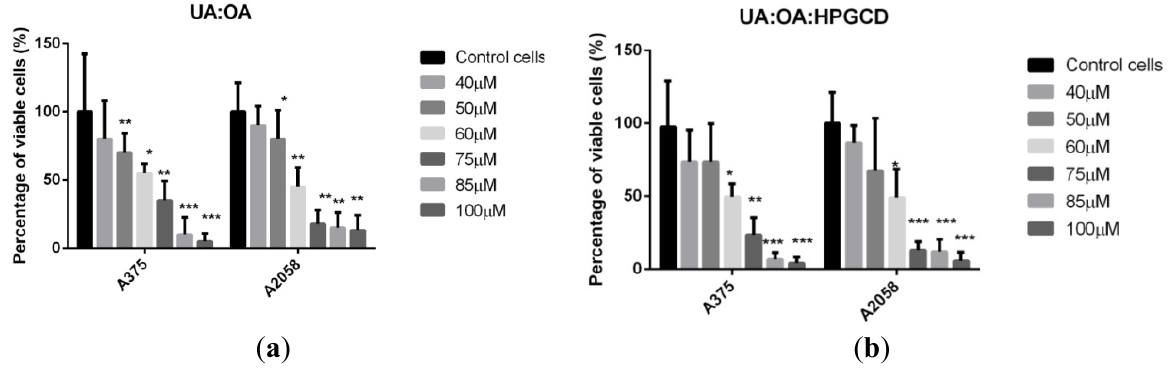
for the concentration of 75 µM ( p = 0.039). For the A2058 cell line the exception occured at the concentration of 100 µM ( p = 0.037). Figure 4. Alamar Blue assay showing the effects of ( a ) UA:OA mixture and ( b ) OA:UA:HPGCD complex, respectively, on the viability of the A375 and A2058 human melanoma cell lines. Viability is expressed as percentage of viable cells compared to the control (considered as 100%). The dilution rate was 1:1000, the concentration of the stock solution was 10 mM, and 1:1 UA:OA final concentrations in the medium were 40 μ